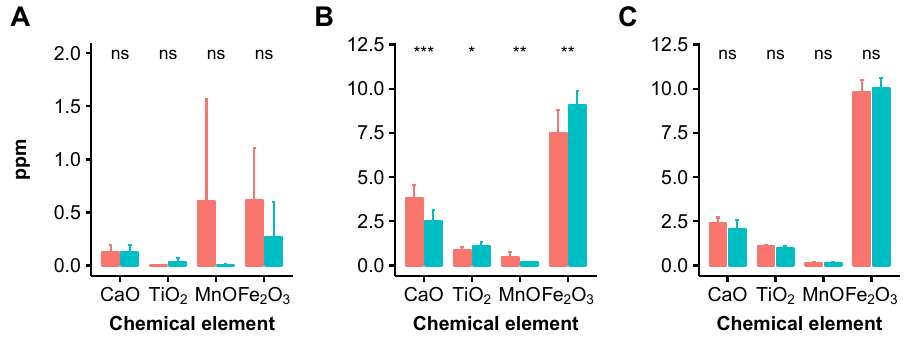
Fig. 3 Boxplot of macroelement content in mushrooms ( A ), surface soil layer ( B ), and deep soil layer ( C ) collected at Site 1 (red) and Site 2 (blue). The element concentration is expressed in ppm. Statistical significance: **** α = 0.001; *** α = 0.01; ** α = 0.05; * α = 0.1; ns – not significant values.